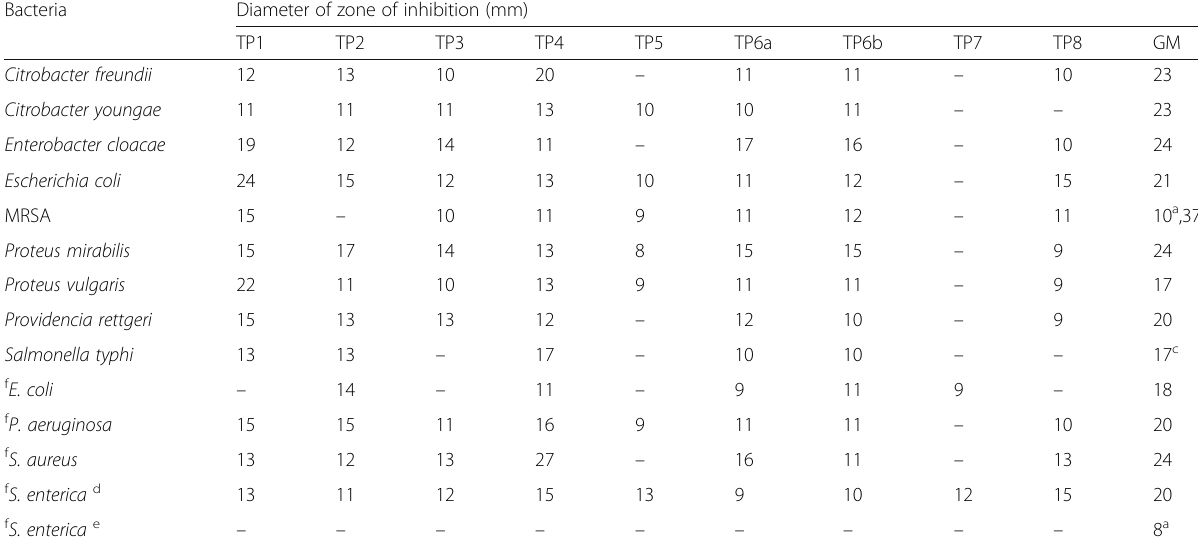
Table 3 Antibiogram of methanol extracts of anti-infective traditional remedies sold in Buea, Cameroon